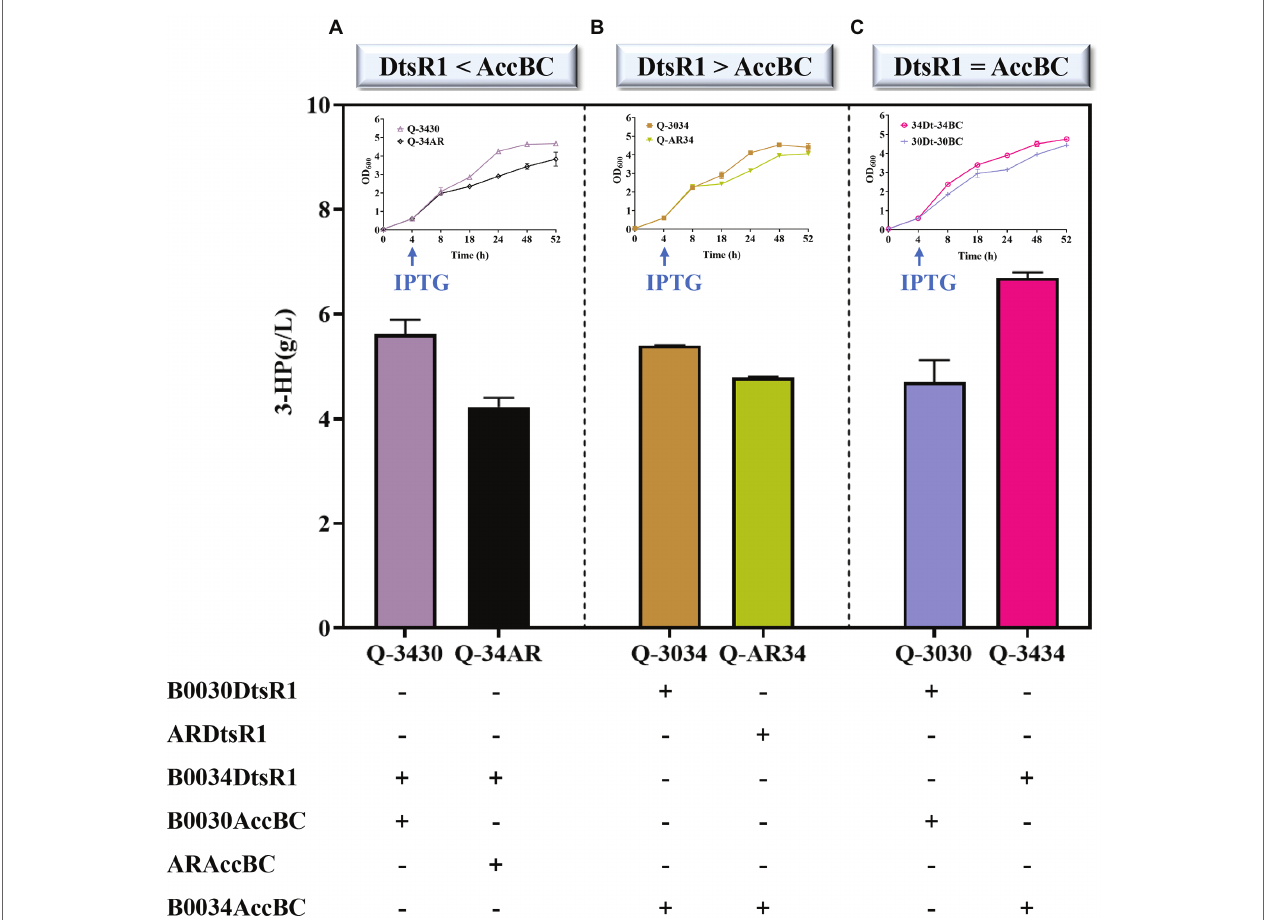
FIGURE 5 | Biosynthesis of 3-HP with adjusted DtsR1 and AccBC expression in a producing strain Q2098. Three expression levels of DtsR1 and AccBC, namely strains (A) Q-3430/Q-34AR (DtsR1 < AccBC), (B) Q-3034/Q-AR34 (DtsR1 > AccBC), and (C) Q-3030/Q-3434 (DtsR1 = AccBC), were studied for their influence on 3-HP production. All results were calculated with three ( n = 3) independent